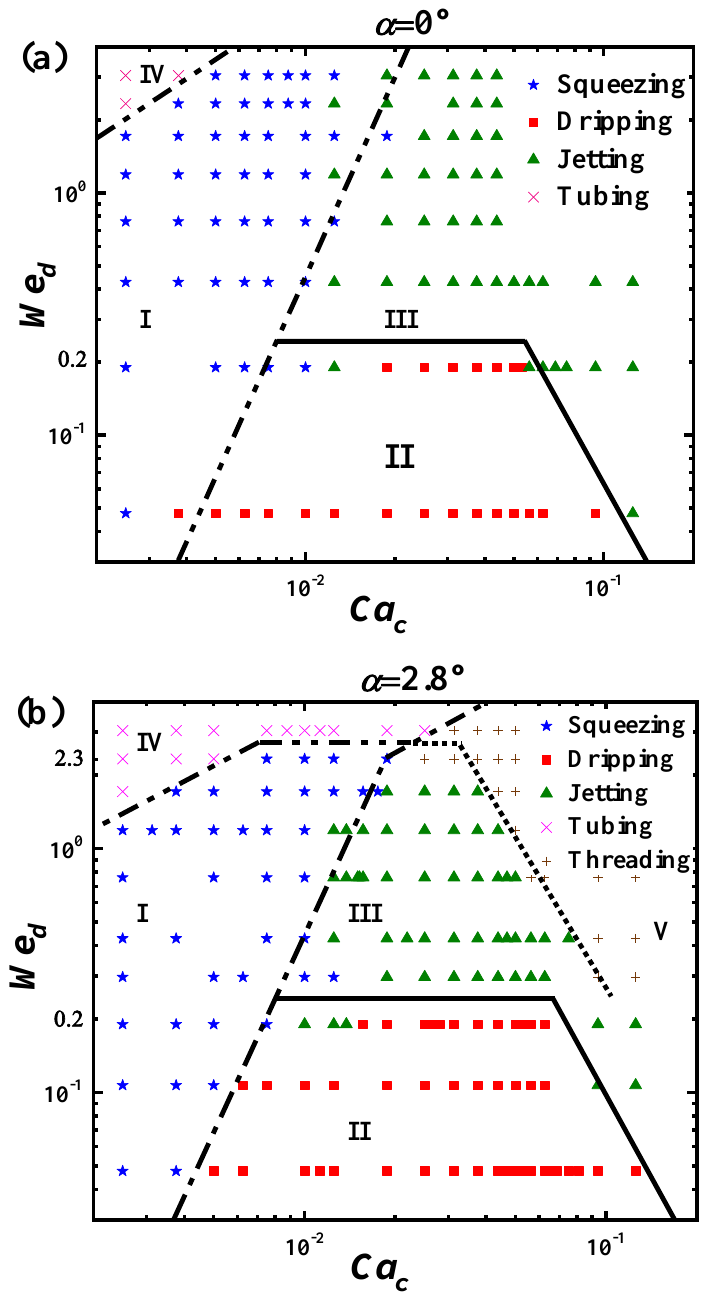
Figure 6. State diagrams in the Ca c – We d space at the two convergence angles. ( a ) α = 0 ◦ and ( b ) α = 2.8 ◦